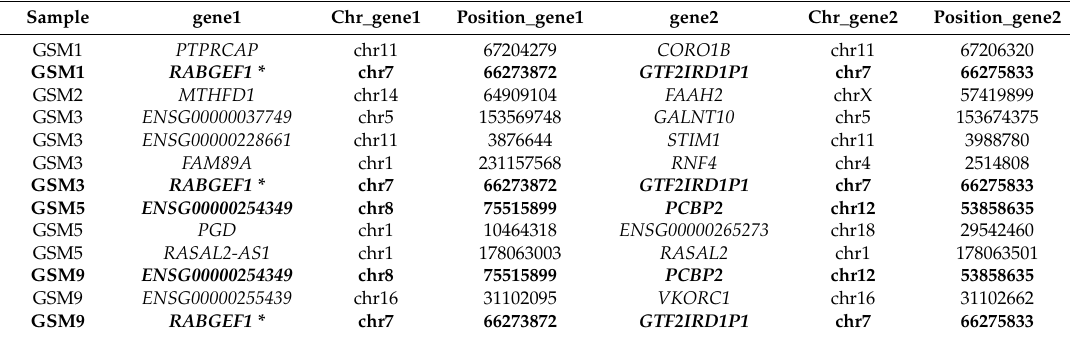
Table 4. Translocations in GSM samples. In bold—translocations discovered in 2 samples, in bold with *—translocations discovered in 3 samples.